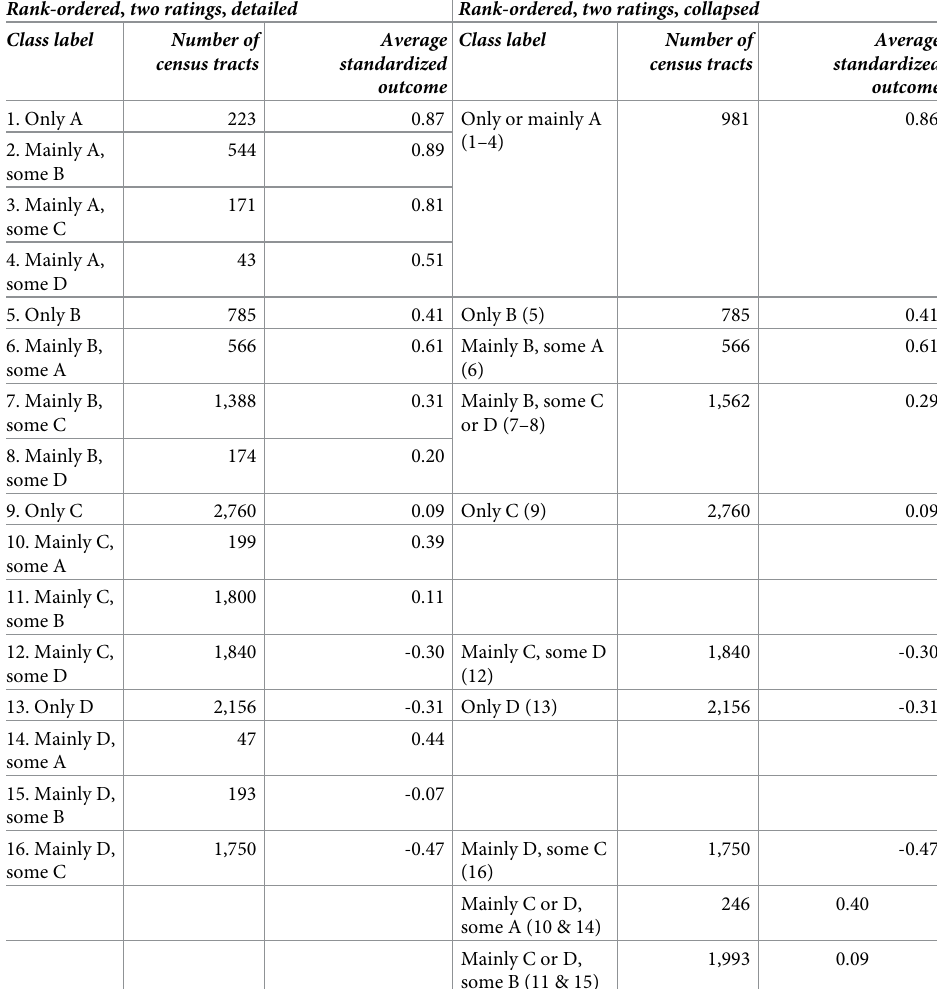
Table 4. Detailed and collapsed rank-ordered, two-rating classification. Rank-ordered , two ratings ,